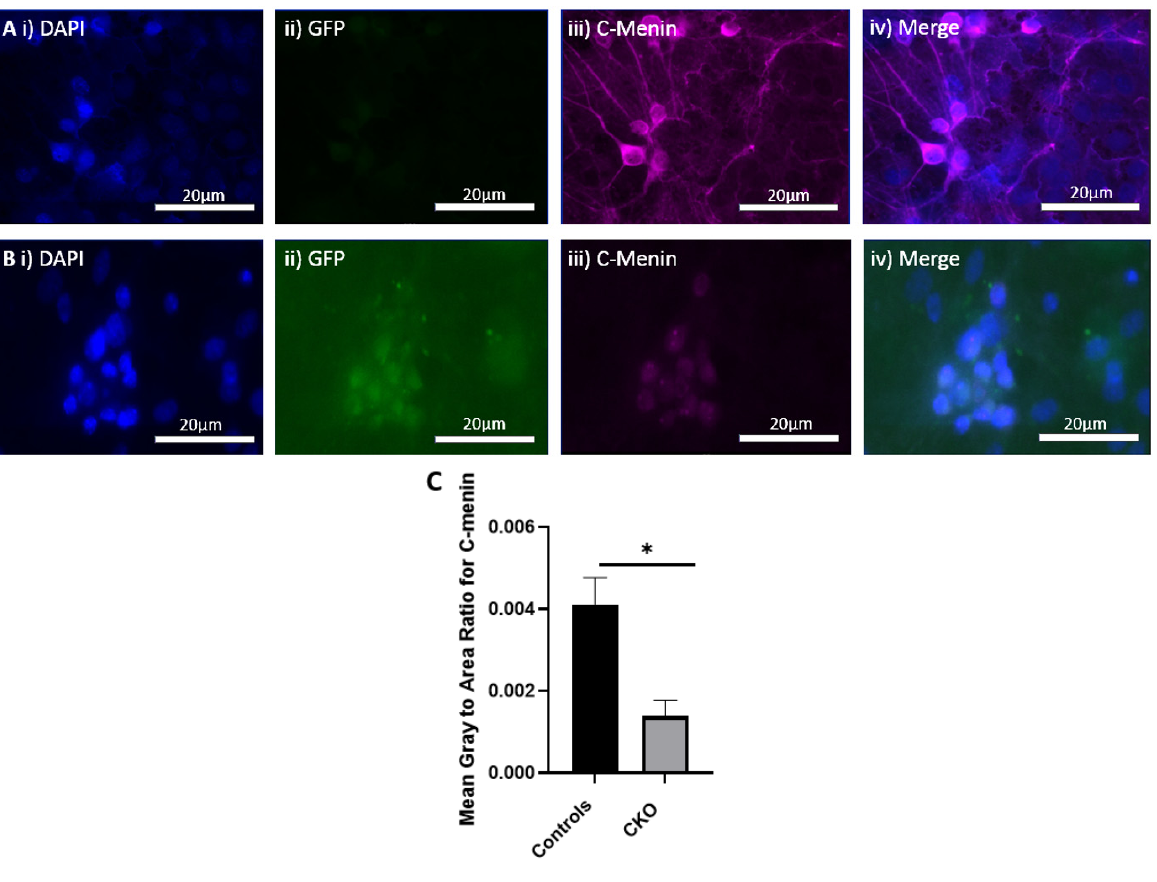
Figure 3. In vitro virus transduction of the hippocampal neurons from MEN1 floxed mice in control and CKO groups. ( A ) Controls with no virus; ( i ) the expression of DAP for nuclear staining; ( ii ) GFP signal in the absence of virus; ( iii ) C-menin showing axoplasmic expression; ( iv ) merge in controls for GFP and DAPI; ( B ) CKOs with virus; ( i ) DAPI for nuclear staining; ( ii ) GFP signal indicating virus transduction in the preparation with the Cre AAV9; ( iii ) C-menin signal weaker compared to the controls; ( iv ) merge in the CKO for GFP and DAPI; ( C ) summary data, showing the reduction in menin signals as measured by mean gray-to-area ratio in the CKO compared to the controls. Data represent the mean ratio ± SEM. n = 4. Statistical significance (Mann–Whitney U test), * p < 0.05.